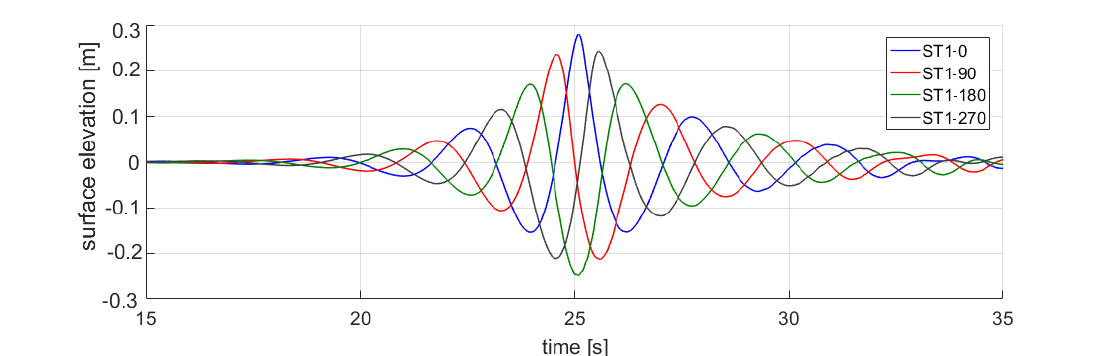
Figure 5. Surface elevations time-series for four of the twelve ST 1- focused